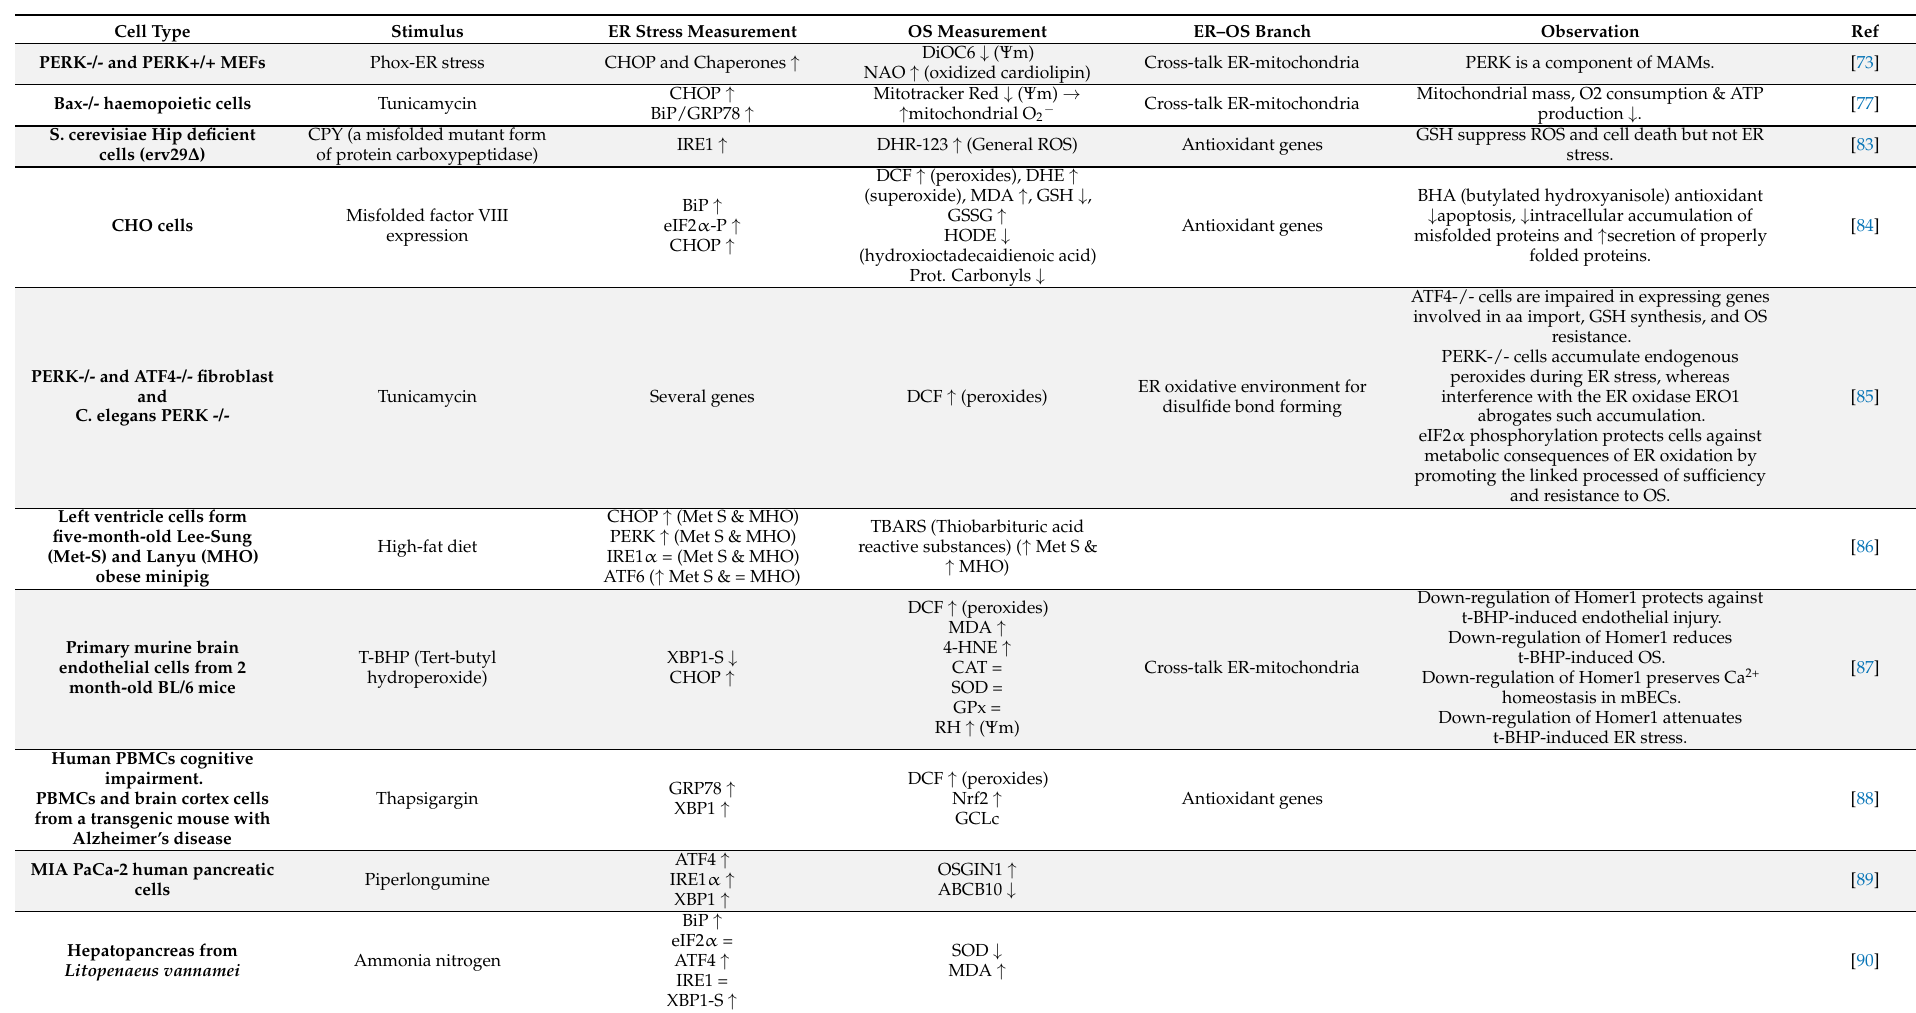
Table 1. Summary of some studies where endoplasmic reticulum (ER) stress and oxidative stress (OS) are present